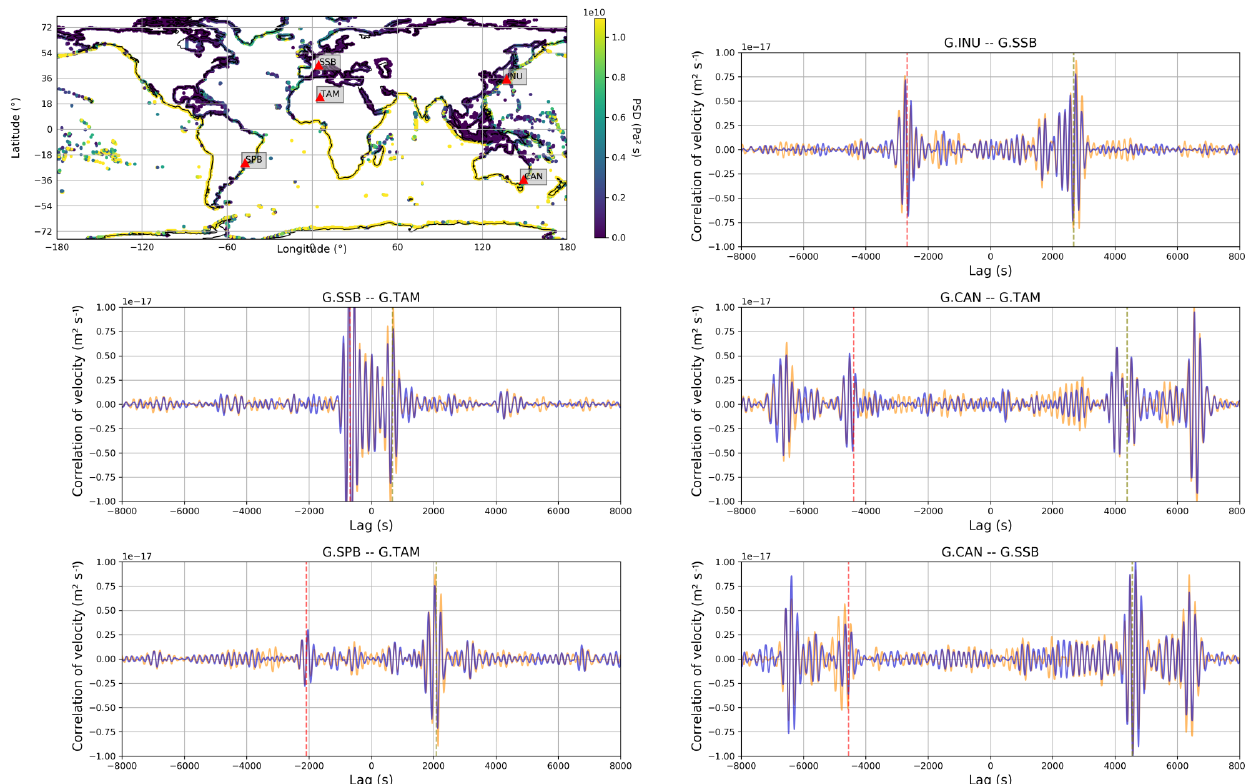
Figure 3. Simulation of cross-correlations due to hum sources modeled akin to Ardhuin et al. (2015) and Deen et al. (2018). Hum sources are localized in small areas constrained to shorelines of continents and islands. Correlations were computed using both anisotropic PREM (yellow) and S40RTS (blue). Localized hum sources cause a host of early-arriving surface wave phases in the cross-correlations. Red and green vertical lines mark the arrival time of a surface wave traveling at 3.7kms − 1